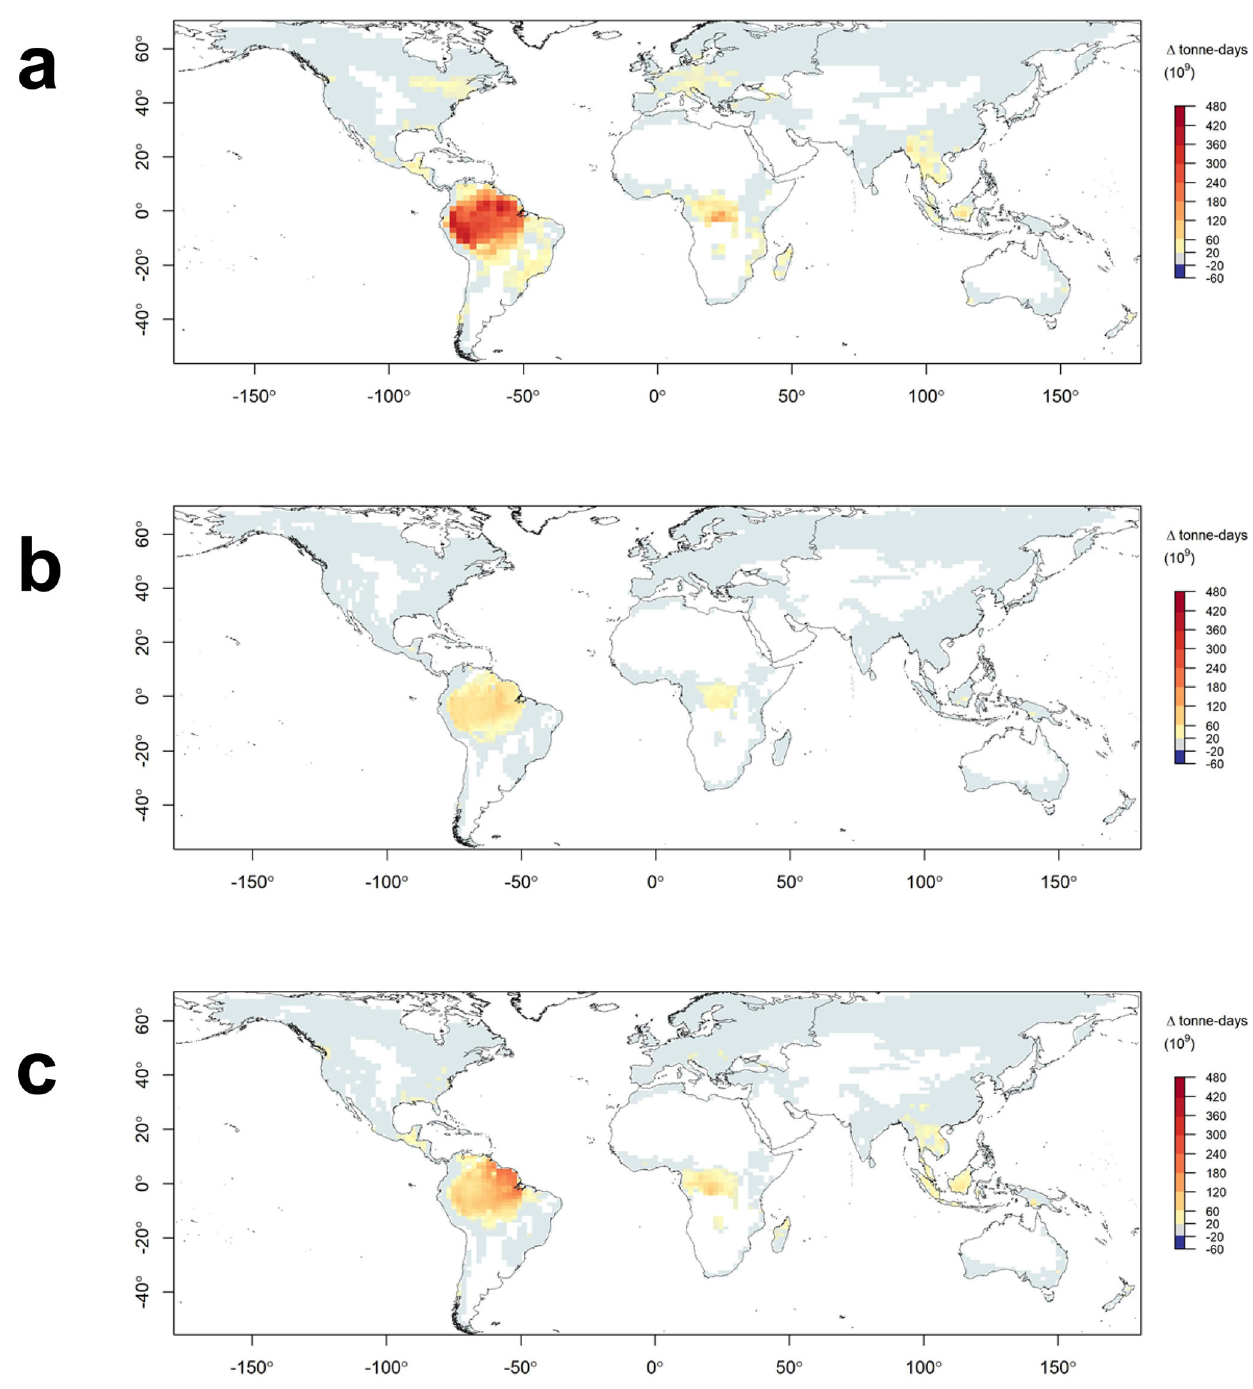
Fig. 4 | Projected change in global forest aboveground biomass exposure to changesinthemeanannualfrequencyofdaysexceedingtheVPDthresholdby 2081 – 2100 under RCP8.5. Results are shown for GFDL-CM3 ( a ), CNRM-CM5 ( b )